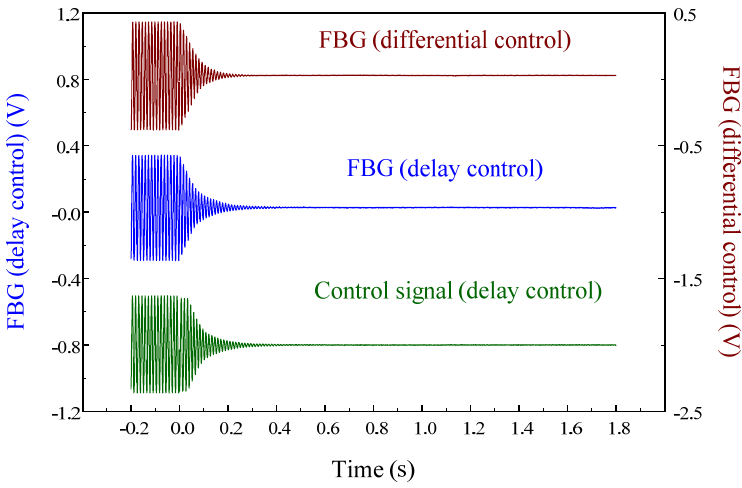
Figure 26. Active vibration control of the smart cantilever beam excited at first resonant frequency (76 Hz) under 3/4 phase delay